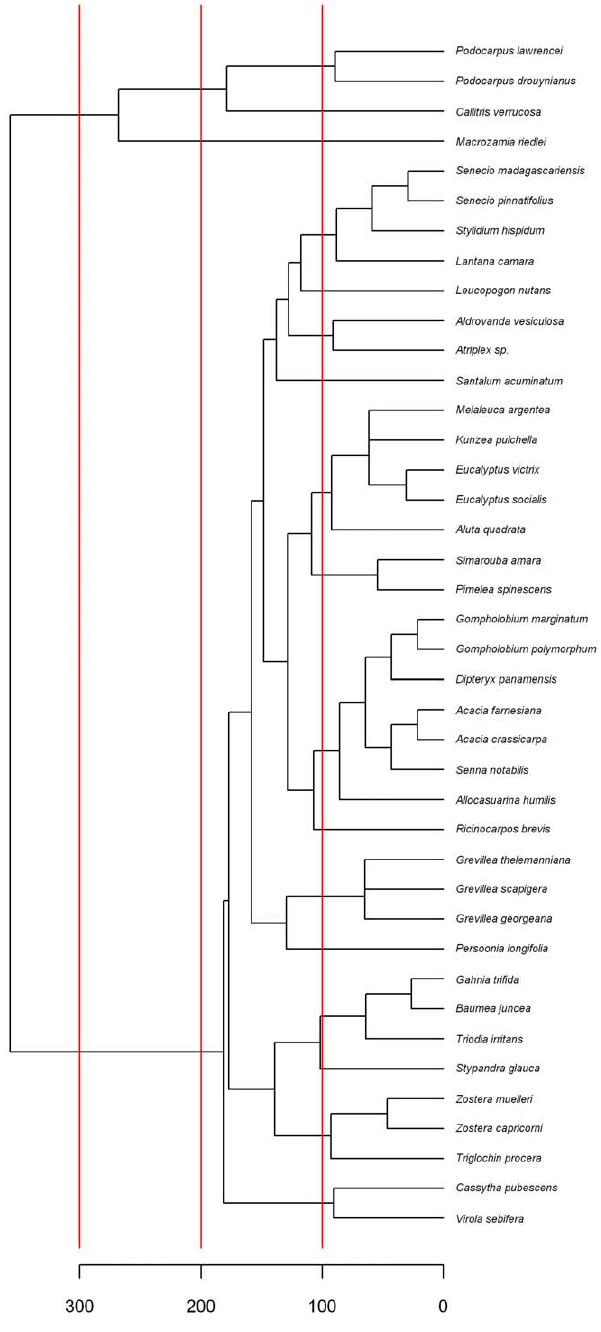
Figure 1. Phylogenetic tree of the animal species studied. The cutoff limits used for autocorrelation analyses of microsatellite coverage are indicated in red.